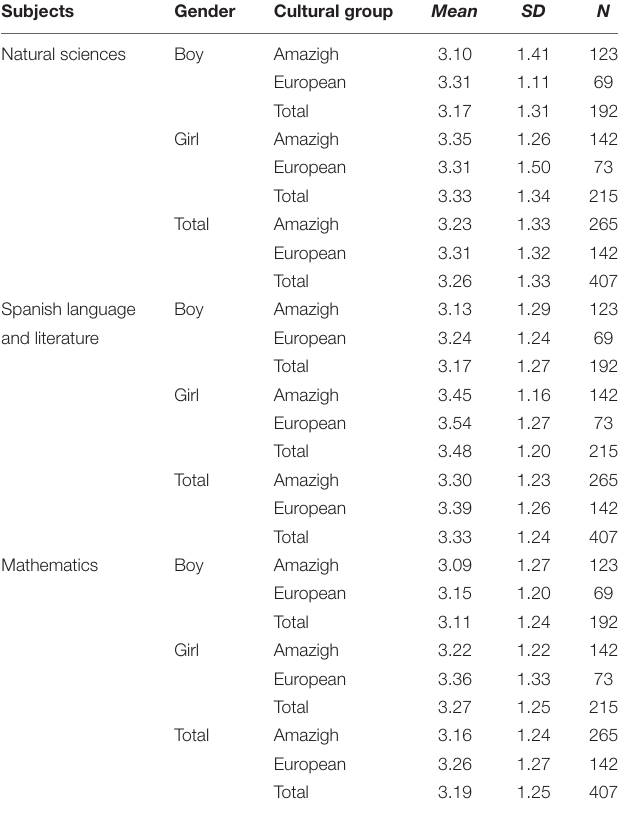
TABLE 3 | Academic achievement by gender and cultural